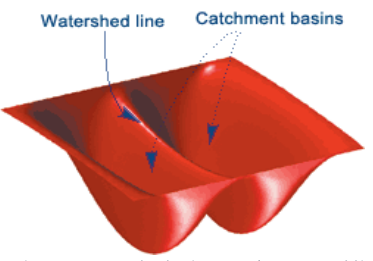
Figure 1 Watershed Diagram (Source: Eddins,